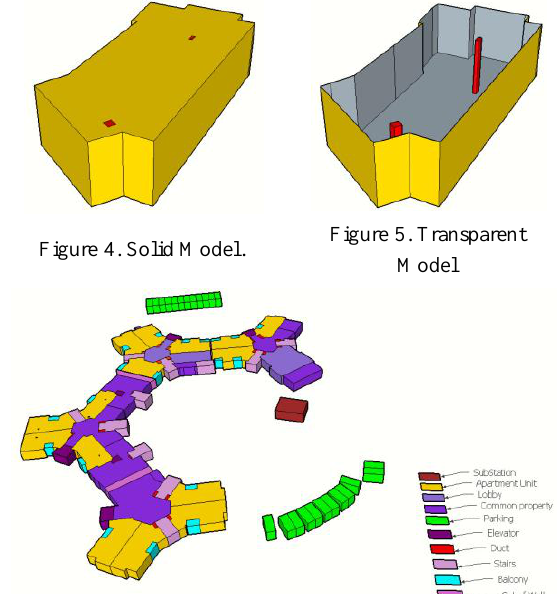
Figure 6. 3D extrusion of ground floors of case study